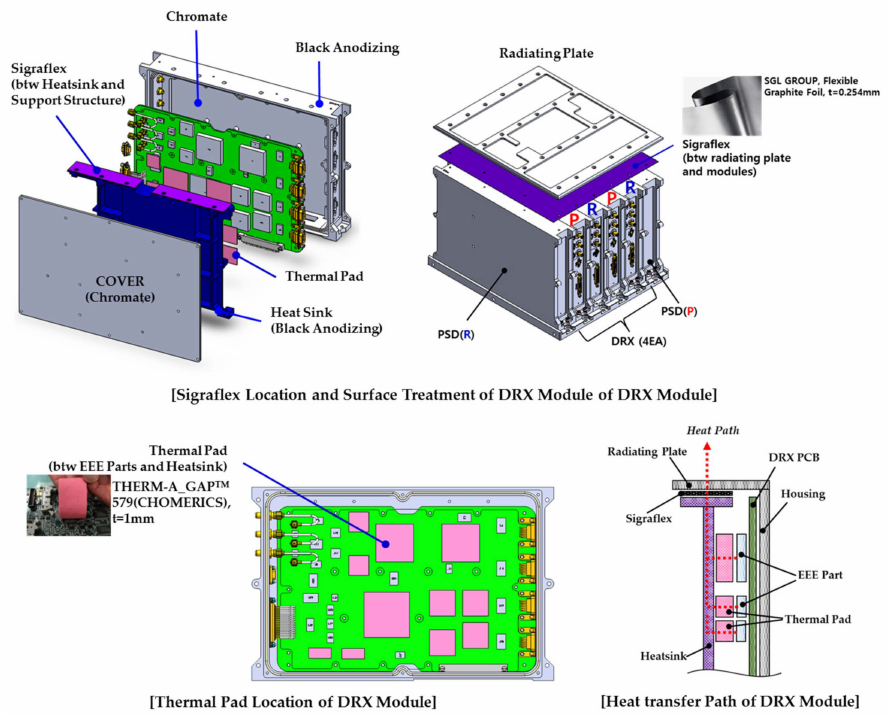
Figure 4. Schematic diagram of the thermal control strategy of DRX and HSDRU.